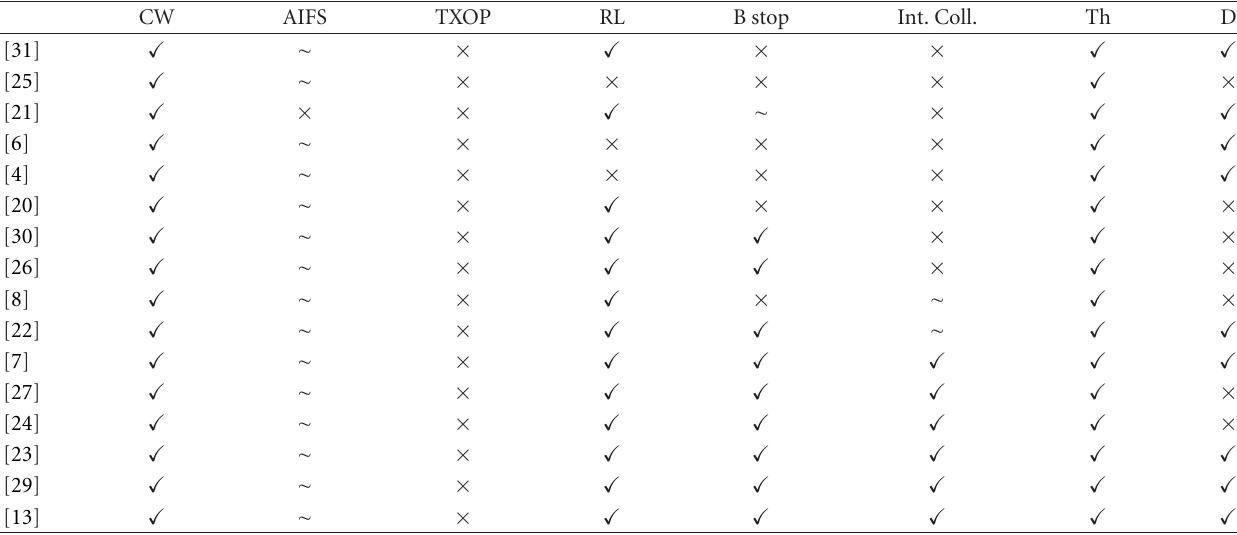
Table 1: Comparison of major EDCA